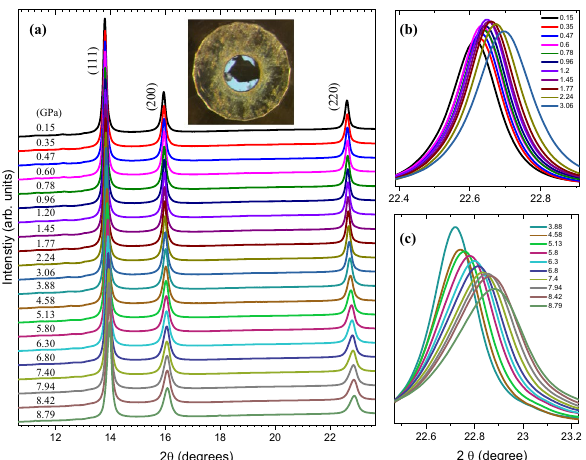
Figure 6. Pressure dependent XRPD data. Panel ( a ) shows the full pattern; panels ( b ) and ( c ) show a zoom into the 220 peak without any vertical shifts. Pressure values are shown in the legends of panels ( b ) and ( c ) with identical colour codes as in ( a ). Inset in ( a ) shows the Cu-Ni sample (black) together with a two ruby balls (white spheres) in the sample chamber (inner circular region). Diameter of the outer circular metallic container is 500 μm, identical as the culet size of the diamonds.